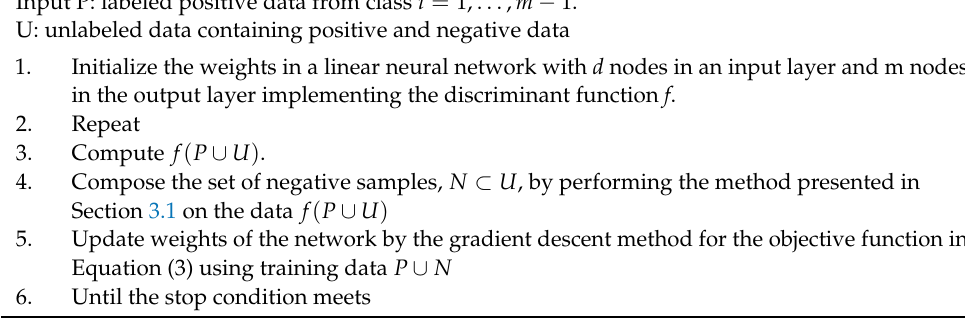
Algorithm 1. The proposed MPU learning algorithm based on outlier detection in the projected lower dimensional space